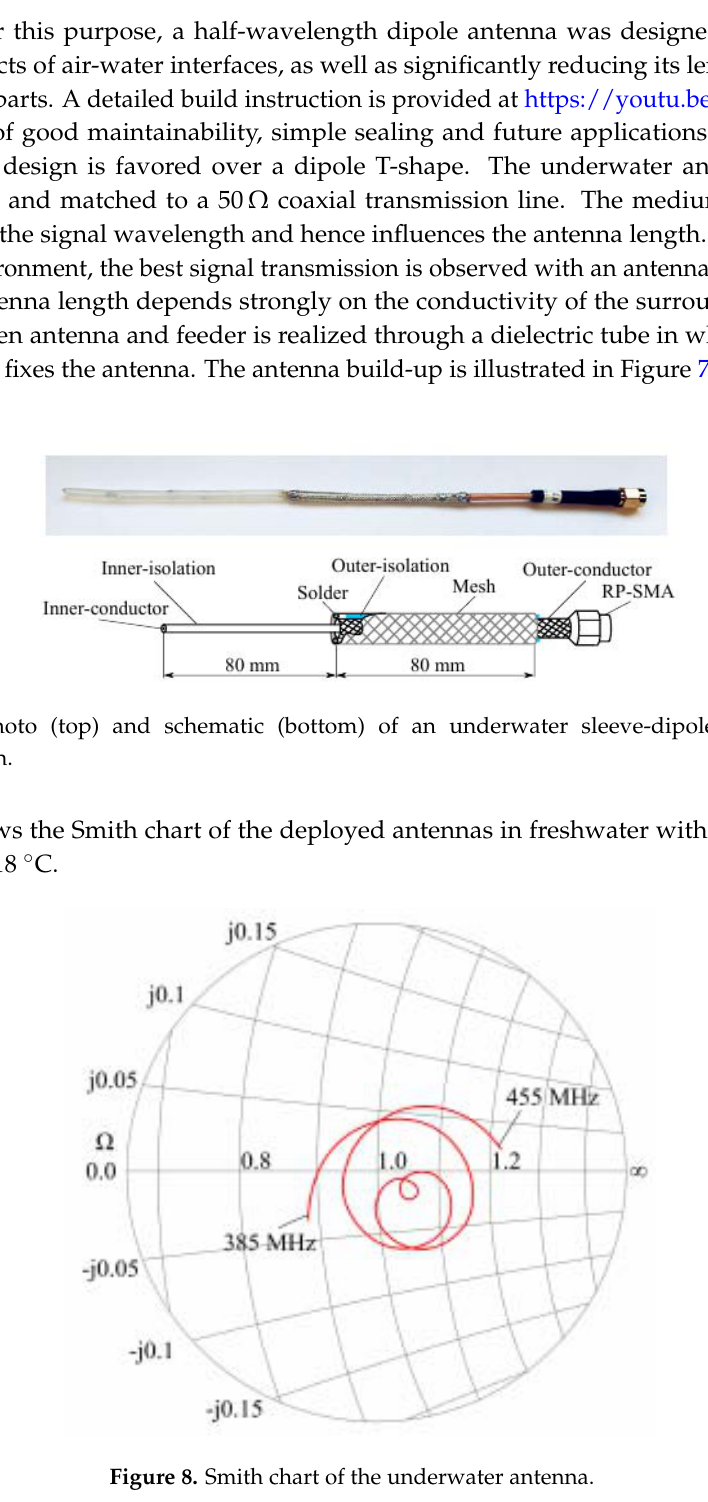
Figure 8. Smith chart of the underwater